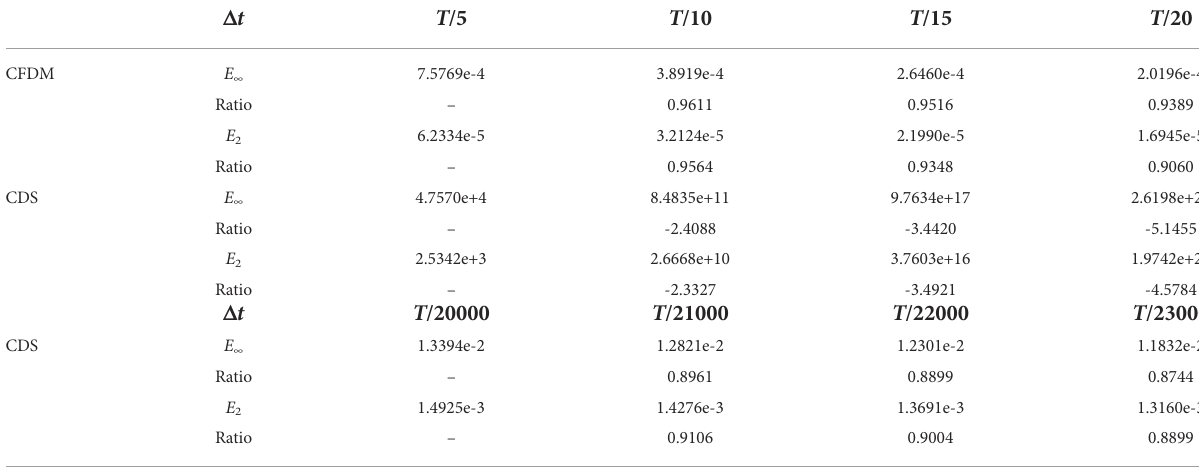
TABLE 2 Errors and ratios in time of the 2D Gaussian pulse for the experiment using large time steps by the CFDM and CDS method and using small time steps calculated by the CDS